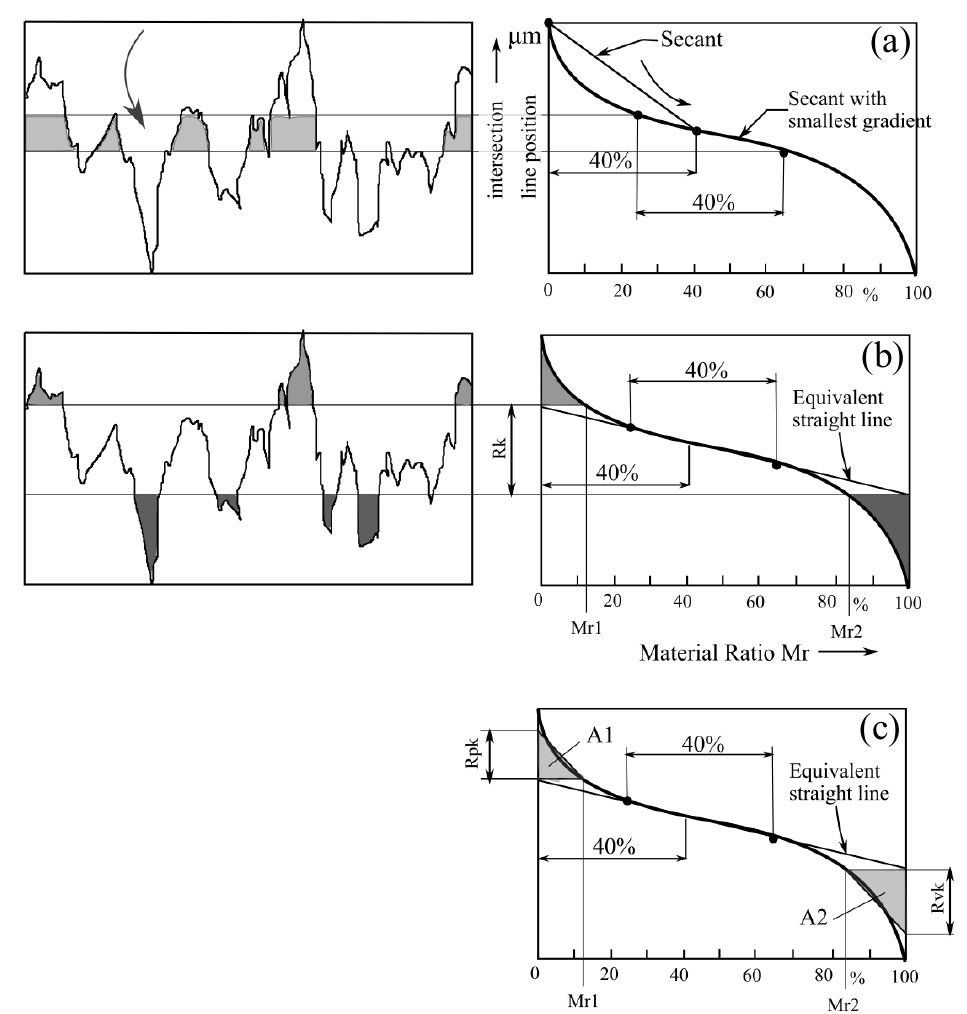
Figure 3. Procedure to evaluate surface parameters from a material ratio curve according to the ISO norms. Rk is the height range corresponding to the equivalent straight line found by shifting a secant, having 40% of width, up to the smallest inclination ( a ). Mr1 and (100 − Mr2) represent the portions of the surface covered by peaks and valleys, respectively, and define the two black regions in ( b ). Rpk and Rvk are the height of the triangles having the same area of those regions ( c ). The procedure for their determination is codified by the ISO4288 standard [30]. The